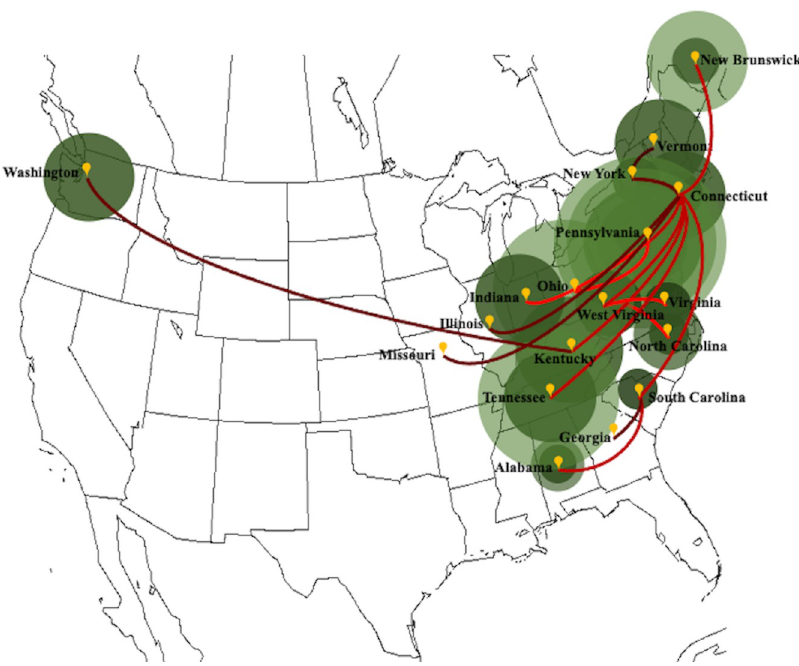
Fig 2. Spread of white-nose syndrome in North America as predicted from PdPV - pa phylogeographic analysis in BEAST and visualized in Google Earth with SPREAD v1.0.7. The area under concentric circles represents the number of branches in that particular location at that time shown by different shades of green. The lines connecting different locations represent branches in the maximum clade credibility tree. The bright to dark gradient of the line’s red color represents the time from 1999 to